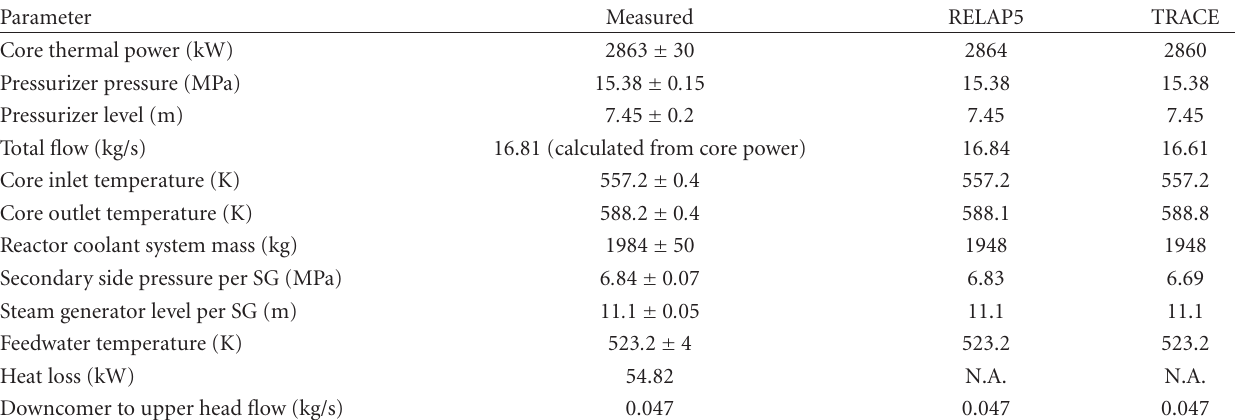
Table 1: Comparison of initial conditions for BETHSY 6.2TC